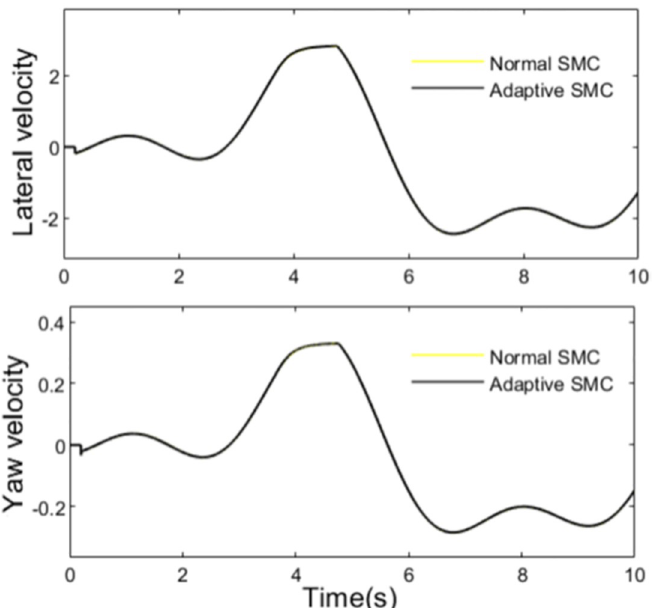
Fig 9. Lateral velocity and yaw velocity.